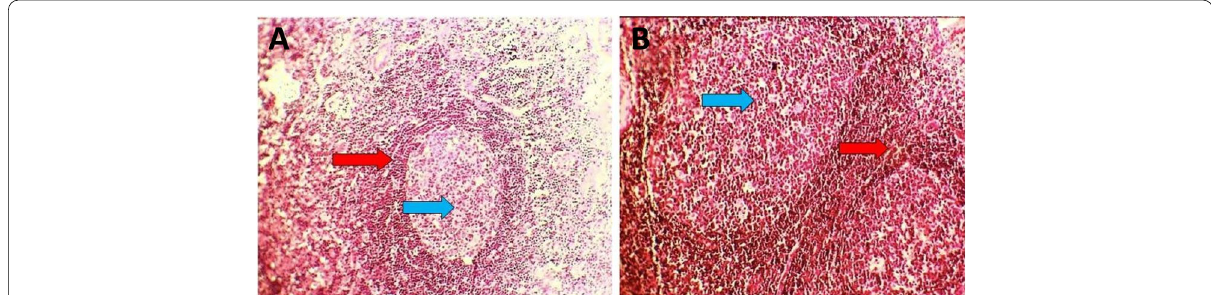
Fig. 3 Showing a benign reactive lymph node, which has a mantle zone (red arrow) that is surrounding a pale germinal center (blue arrow). A H&E 40 and B H&E 100 × ×